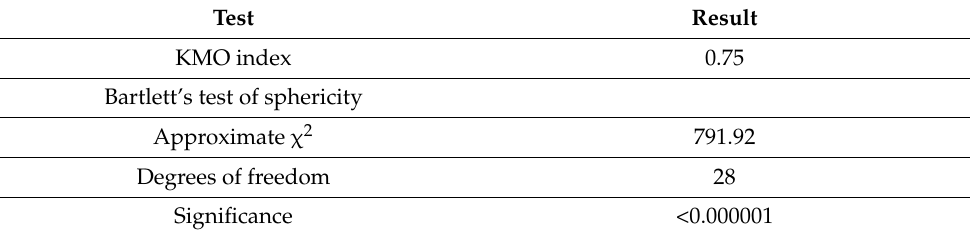
Table 4. Results of KMO and Bartlett’s tests calculated for parameters investigated during processing of sausages.